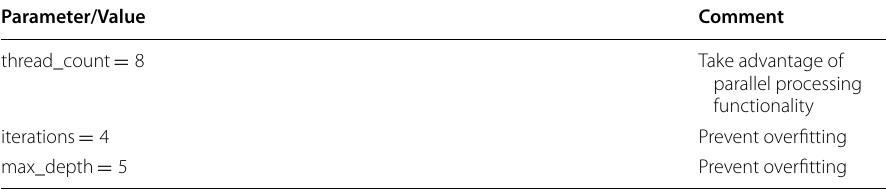
Table 16 Supervised ranking classifier CatBoost initialization options